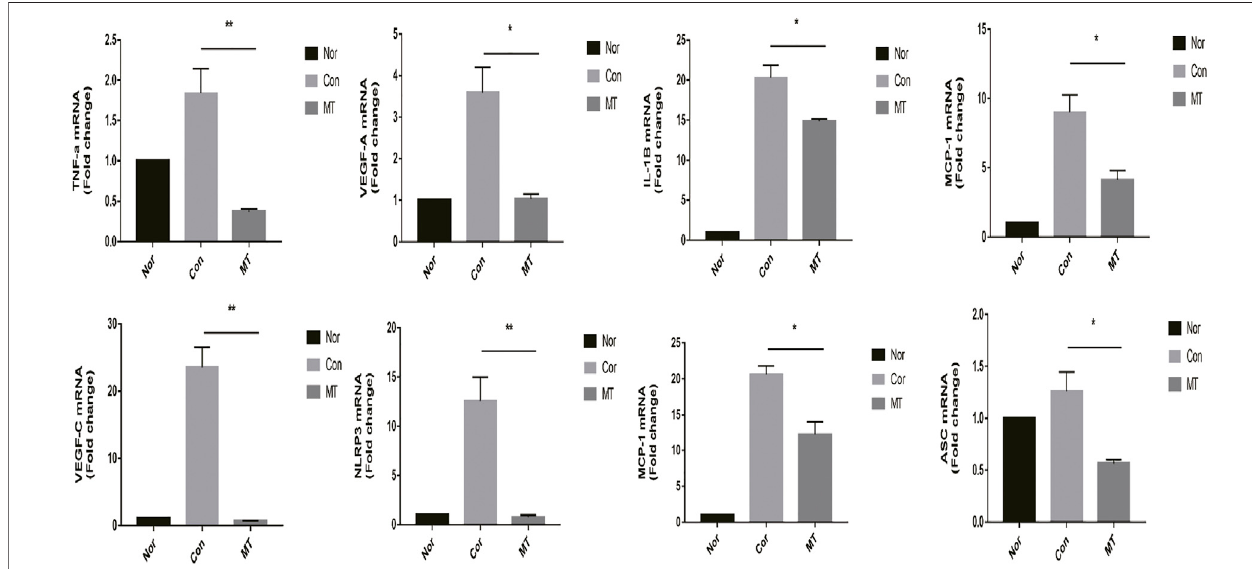
FIGURE 3 | MT inhibits the expression of chemokines and proin fl ammatory factors in the cornea. On the 9th day after surgery, the mRNA expression levels of relevantcytokinesinthegraftsweredeterminedbyquantitativeRT-PCR( n (cid:1) 4pergroup).(Nor:Normalgroup;Con:controlgroup;MT:treatedwithMT).* p < 0.05,** p < 0.01, *** p <